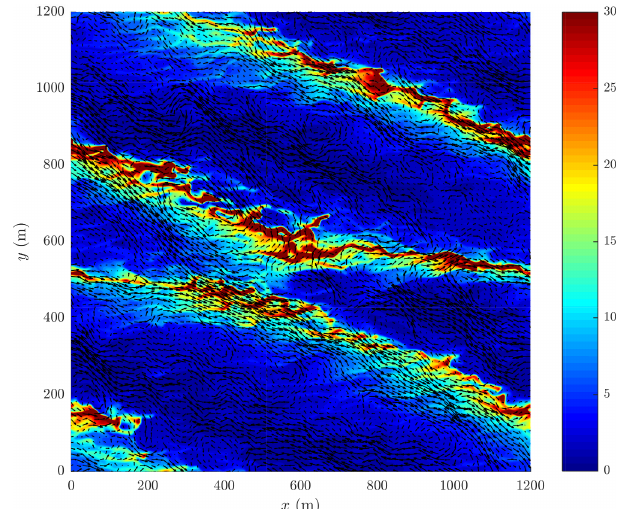
Figure 12. Volume fraction of the largest frazil size class, c 3 / ˜ c 3 , at the sea surface (color) and anomalies of the vertically integrated horizontal currents (arrows) in simulations with U a = 30ms − 1 and T a = − 20 ◦ C for series F all . For better visibility, only every fifth arrow in each direction has been plotted.